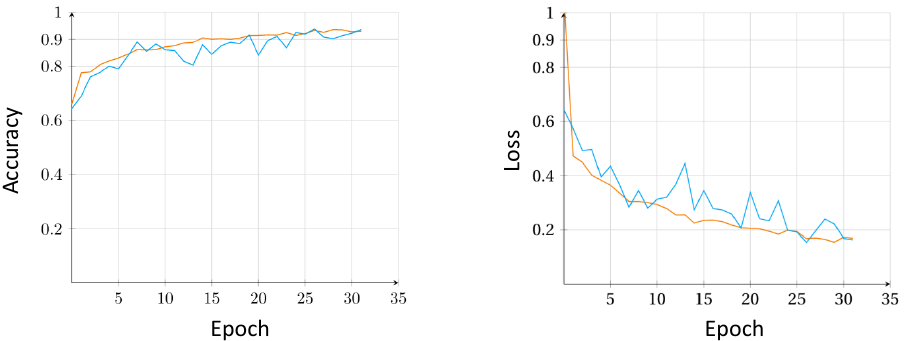
Figure 4. The accuracy and loss graphs of model Model 5 in Experiment 3. Orange and blue lines represent the training and validation phase, respectively.